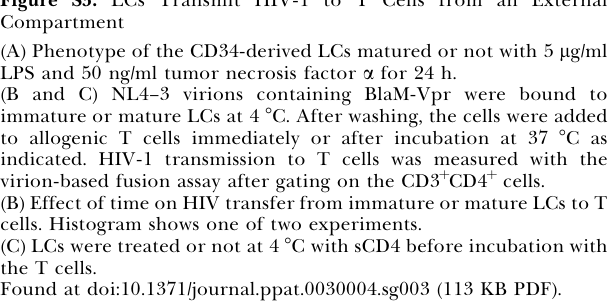
Figure S3. LCs Transmit HIV-1 to T Cells from an External